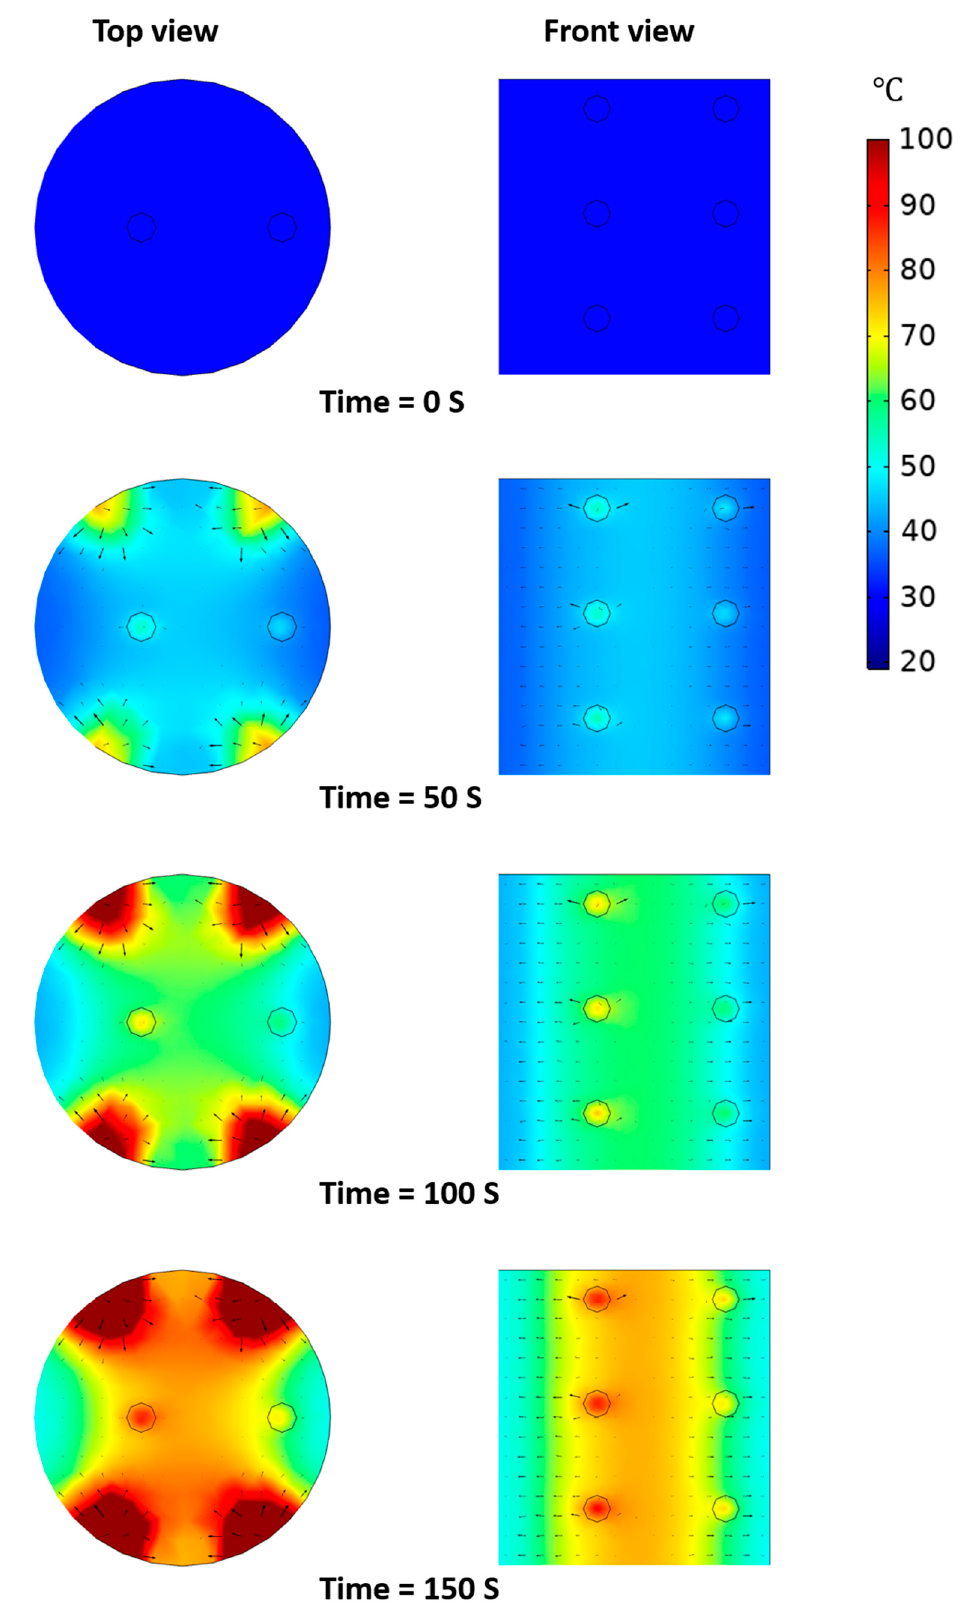
Figure 9. Simulated heating pattern of model food under OH without agitation.